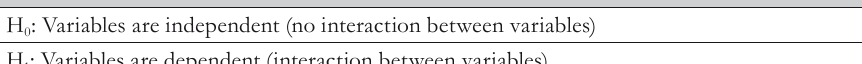
Tab. 4 - Q1b Chi-squared Test and p-value. Source: authors Pearson’s Chi-squared test with simulated p-value (based on 5000